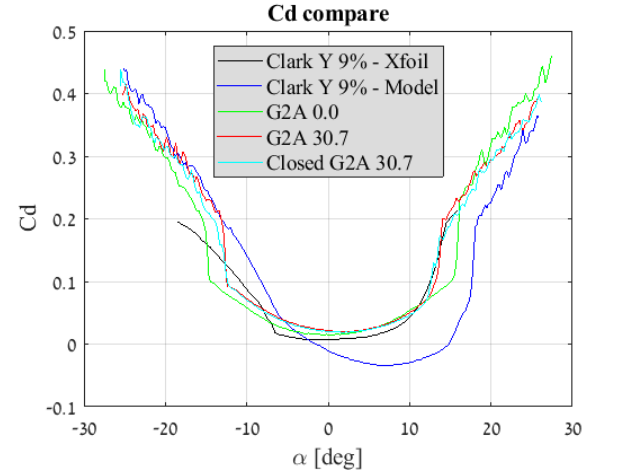
Figure 24. Drag coefficient vs. angle of attack comparison of the four tested wing segments.